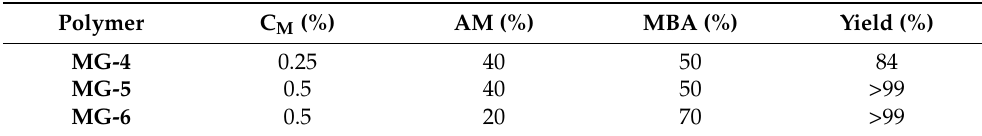
Table 5. Microgels (MGs) synthesized using 10 mol% 4-vinylimidazole (4VI), acrylamide (AM), and N,N (cid:48) -methylenebisacrylamide (MBA), and 10% w/w ammonium persulfate (based on the total moles of double bonds) in de-ionized water at 70 ◦ C or for 24 h together with their chemical